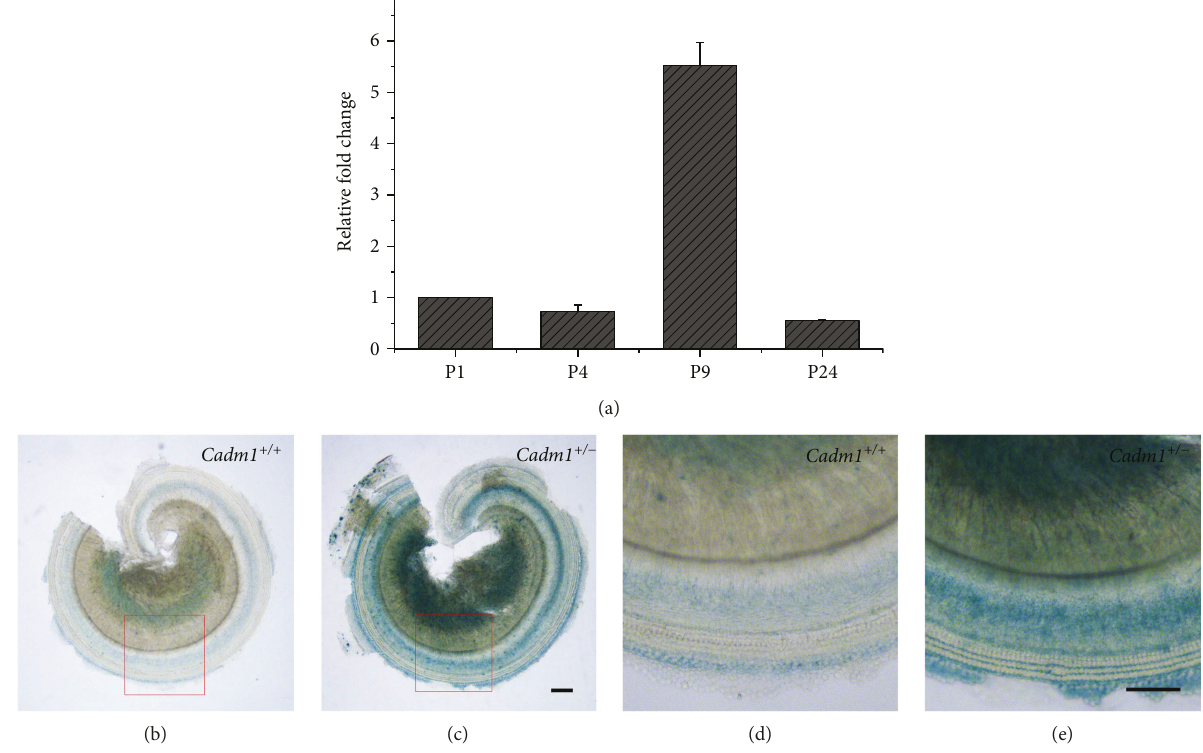
Figure 6: Expression pattern of Cadm1 in mouse inner ear. (a) Expression of Cadm1 in di ff erent developmental stages of mouse inner ear examined by Q-PCR. The bar graphs show quanti fi cation of the PCR results with each value representing the mean ± standard error. (b) LacZ activity in the basilar membrane and spiral ganglion of P7 Cadm1 +/+ mice. (c) LacZ activity in the basilar membrane and spiral ganglion of P7 Cadm1 +/ − mice. (d) Higher-magni fi cation image from the insect of (b). (e) Higher-magni fi cation image from the insect of (c). Scale bars, 100 μ m.